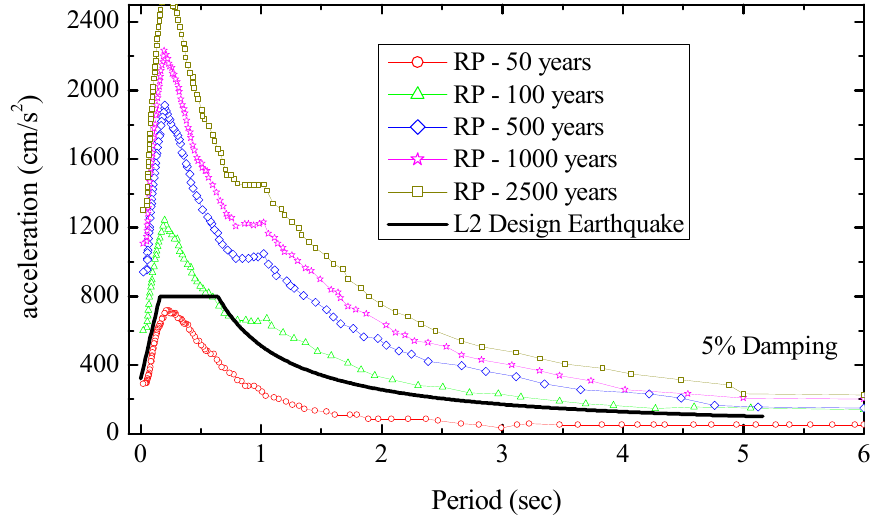
Figure 10. Uniform hazard spectrum provided in AIJ (2019) for Nagoya city, Aichi, Japan.